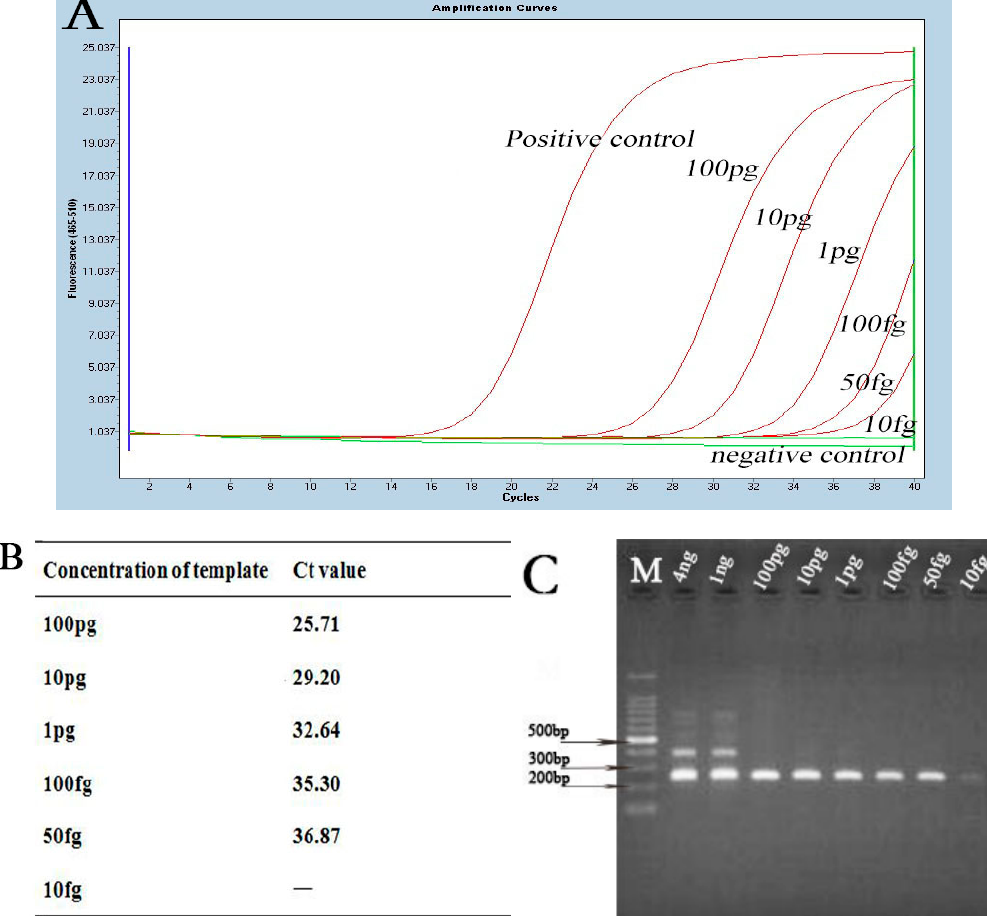
Figure 4. Detection of a series of diluted B. burgdorferi DNA by real-time qPCR and nested-PCR. ( A ) The results of diluted DNA detected by real-time qPCR. C t value for each concentration is shown in this figure ( B ); ( C ) results of diluted DNA detected by nested-PCR. M stands for